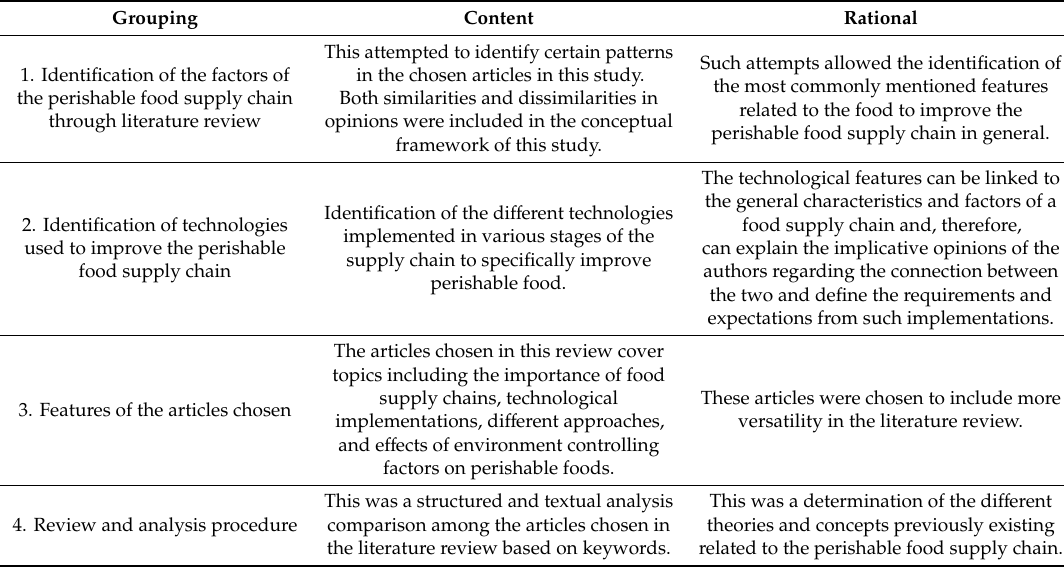
Figure 4. Distribution of research articles in the literature. Table 1. Literature review classification